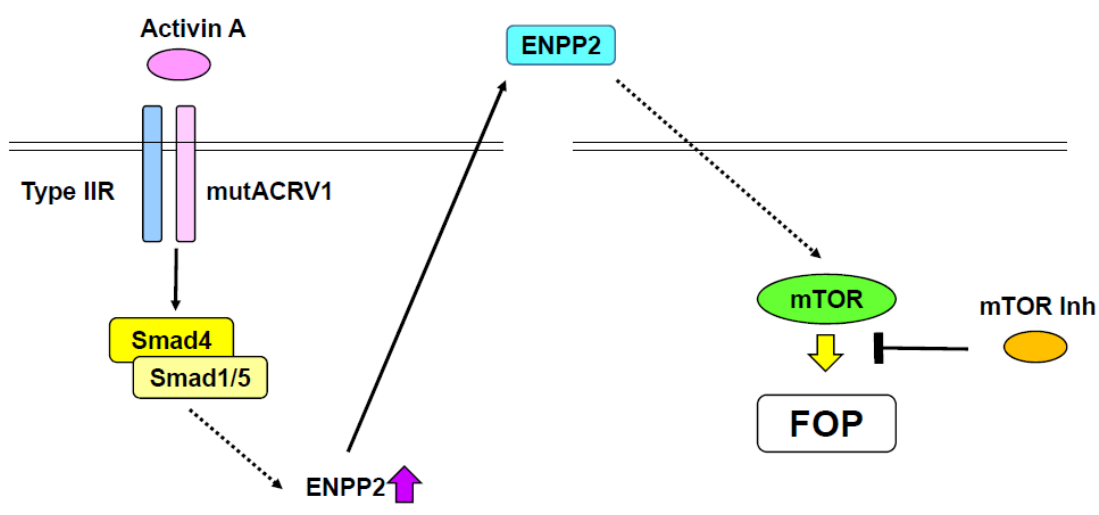
Figure 2. Potential therapy for fibrodysplasia ossificans progressive (FOP). A gain ‐ of ‐ function mutation of ACVR1 (mutACVR1) induces ENPP2 expression by activating the Smad